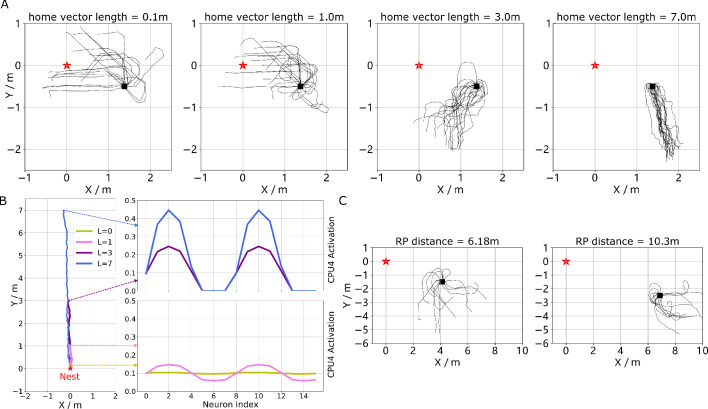
The extended homing paths and the PI memory in the simulations.(A) The extended homing path of 20 agents released at RP1 in Figure 3B with different home vector length. (B) The activation of CPU4 neurons (PI memory) encoding home vectors with different lengths from 0 to 7.0 m. (C) The extended homing paths of 20 agents released at RP2 and RP3 in Figure 3B.